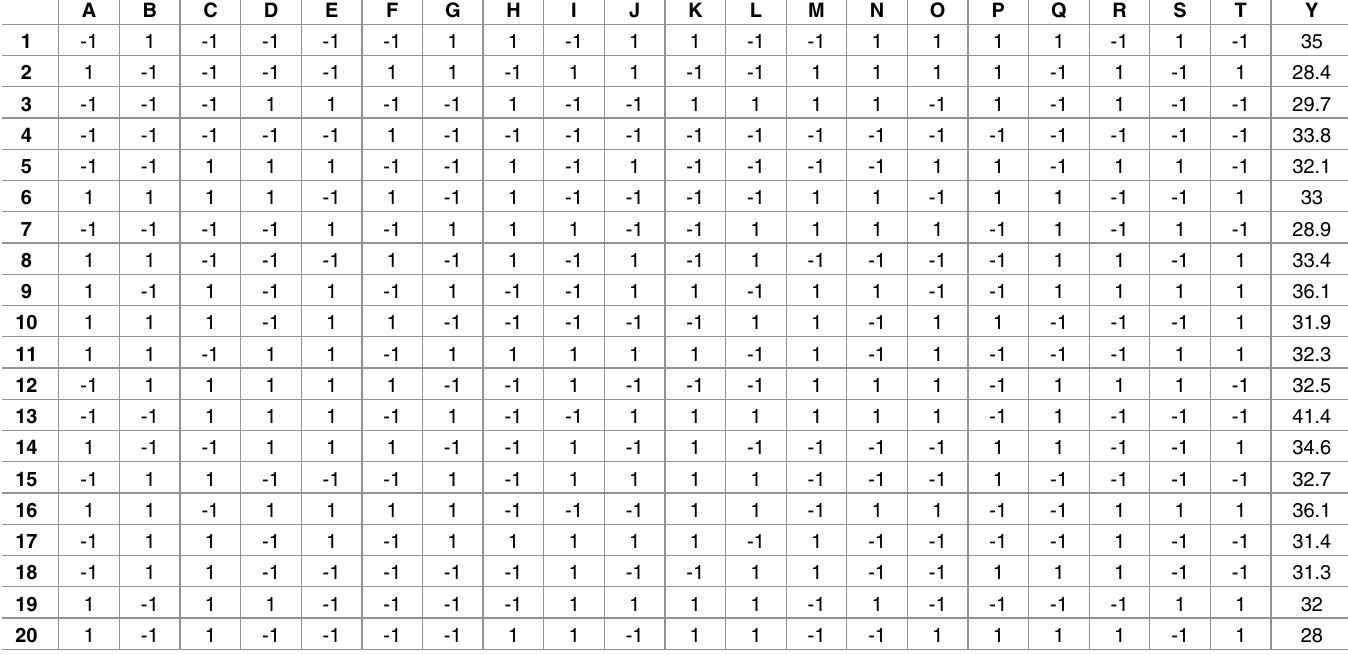
Table 2. Plackett-Burman matrix of the experimental